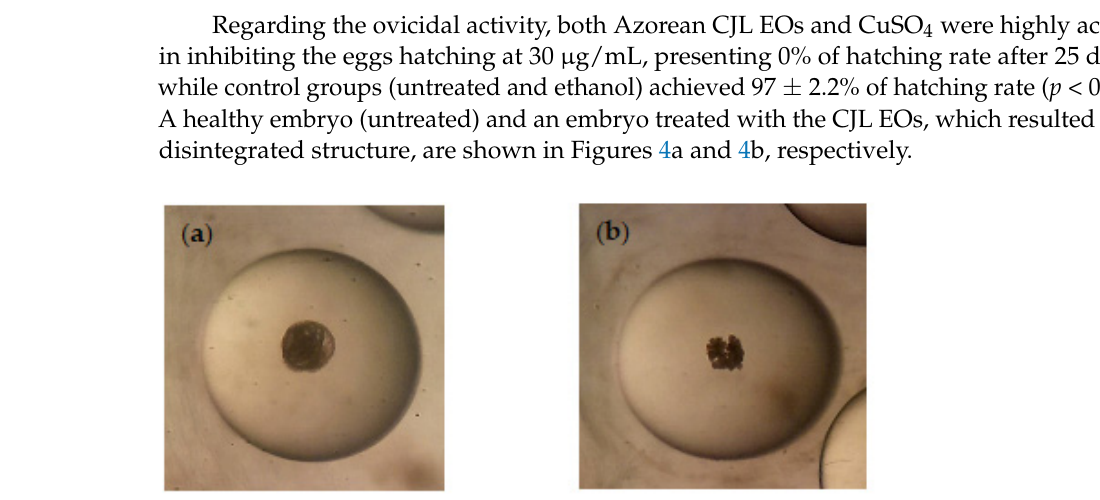
Figure 4. Radix peregra embryo in immersion test. ( a ) Healthy embryo of R. peregra (untreated); ( b ) Disintegrated embryo of R. peregra treated with Azorean Cryptomeria japonica leaf essential